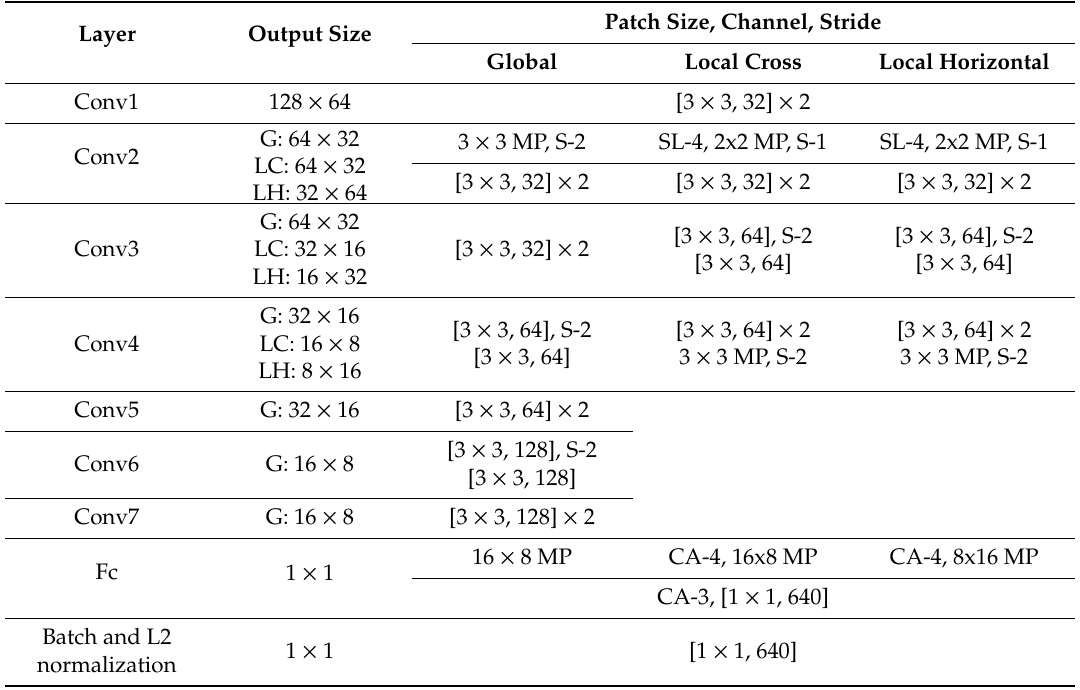
Table 1. Proposed appearance extracting structure. MP: Max-Pooling; S: Stride; SL: Slice;